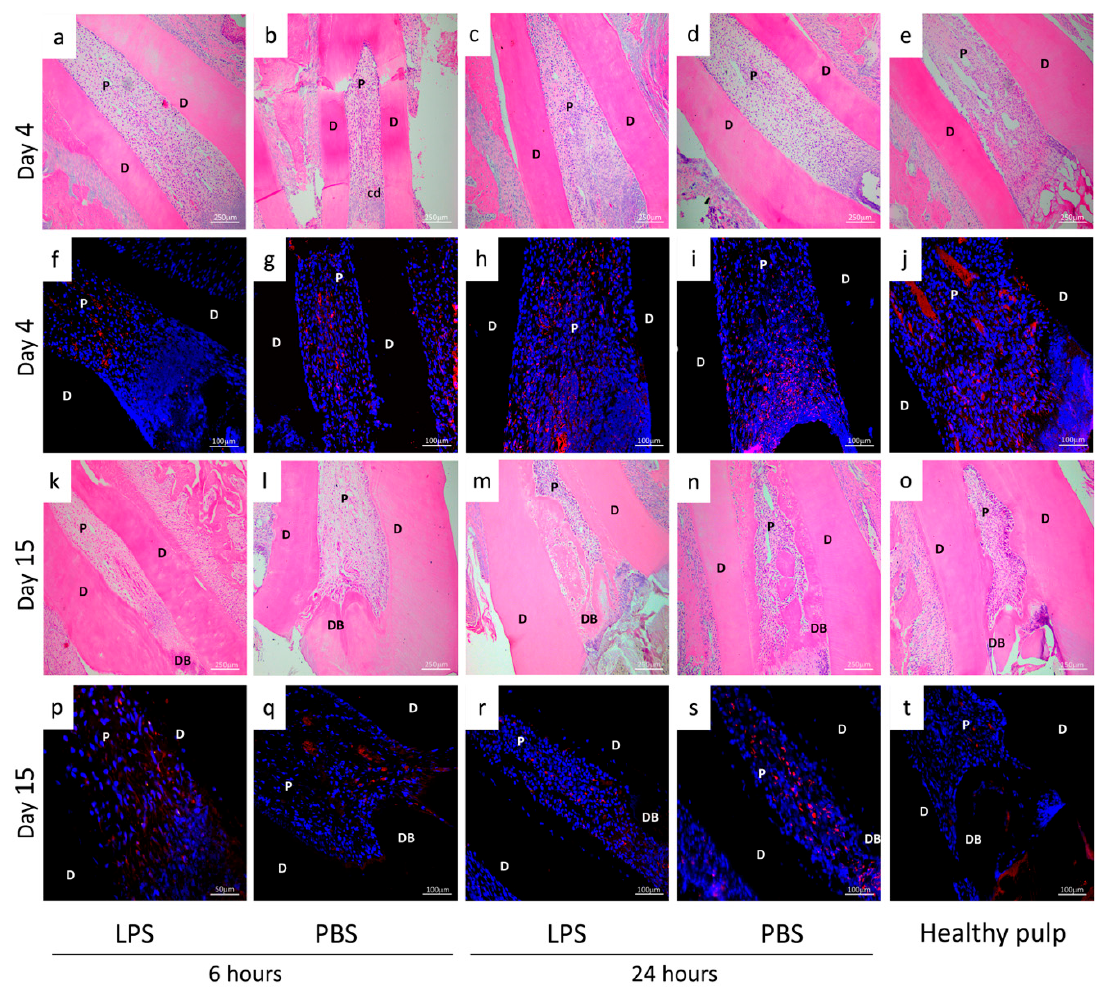
Figure 3. Inflammation analysis by histology and immunochemistry. Hematoxylin-eosin staining ( a – e , k – o ) and immunofluorescence (CD68 label) ( f , j , p , t ) analysis of non-inflamed pulp (healthy pulp) and experimental rat pulpitis induced by phosphate-buffered saline (PBS) or lipopolysaccharide (LPS) treatment observed at 4 and 15 days, after 6 or 24 h of induction. Four days after the pulpotomy, hematoxylin and eosin-staining revealed characteristics of inflammation in all groups. More specifically, CD68 immunohistochemistry highlighted more CD68-positive cells after 24 h (LPS/PBS) ( h , i ) than 6 h (LPS/PBS) of induction ( f , g ). The labelling is found mainly in the coronal third of the root very close to the cellular degeneration area. Fifteen days after the pulpotomy, the inflammation had resolved in the pulp with 6 h of induction (LPS/PBS) ( p , q ) and healthy pulp ( t ). A few macrophage cells remained in the pulp with 24-h induction with PBS/LPS ( r , s ). D: dentin,